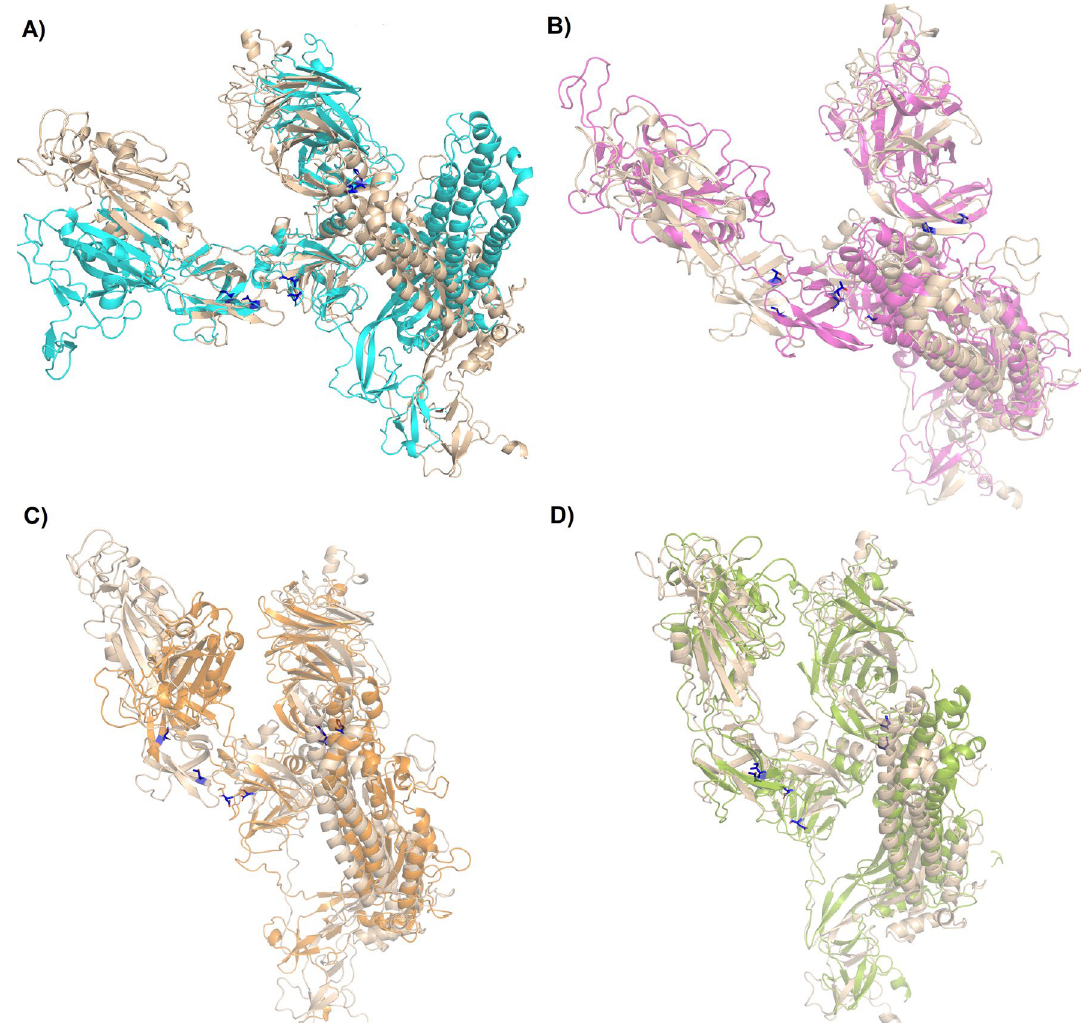
Figure 3. Structural alignment between the starting conformation and the most populated cluster on the trajectory of MDS. ( A ) WT, ( B ) D614G, ( C ) H49Y, and ( D )